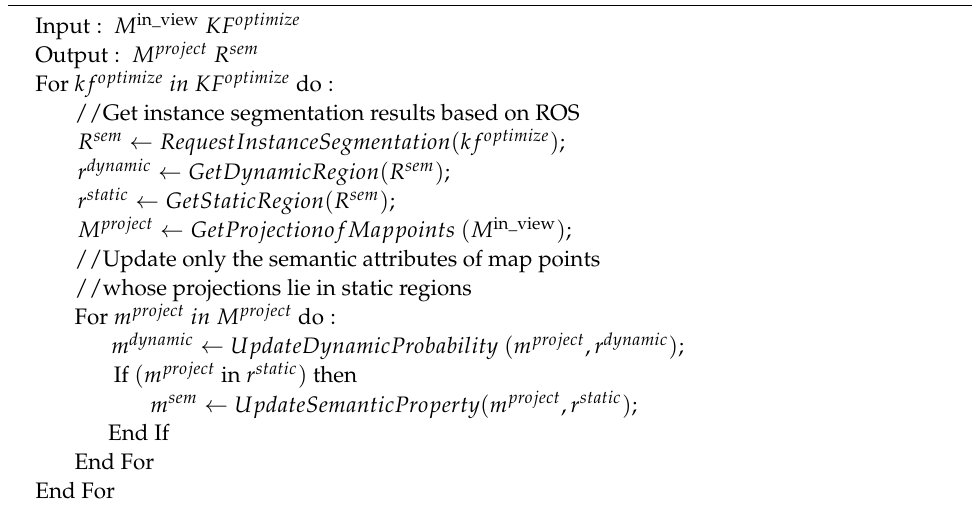
Algorithm 1 Update dynamic probability and semantic properties of map points